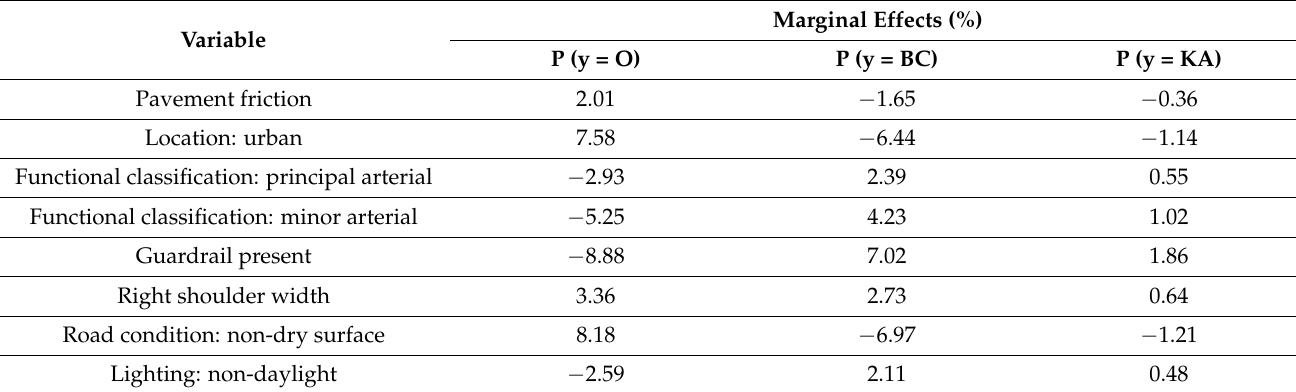
Table 3. Marginal effects of the intersection crash severity